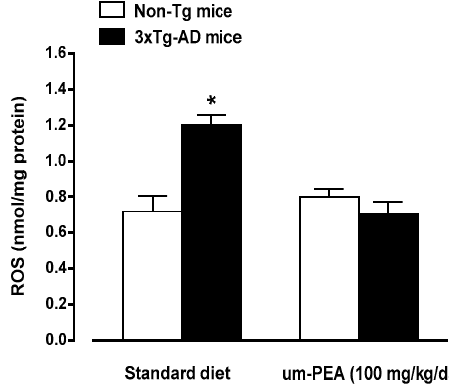
Figure 5. E ff ects of oral ultramicronized palmitoylethanolamide (um-PEA) treatment on reactive oxygen species (ROS) production in hippocampus homogenates from non-Tg and 3 × Tg-AD mice. Age-matched non-Tg mice and 3 × Tg-AD mice (2 months ± 2 weeks of age) have been orally treated for 3 months with the compound (100 mg / kg / day, added to the animal food), while control animals were fed with a standard diet during the treatment period. ROS production was measured in hippocampus tissues taken from mouse brains at the end of the treatment period. The data are presented as mean ± SEM ( n = 5, in triplicate). * p < 0.05 significantly di ff erent from the other groups according to two-way ANOVA followed by Tukey multiple-comparison test.